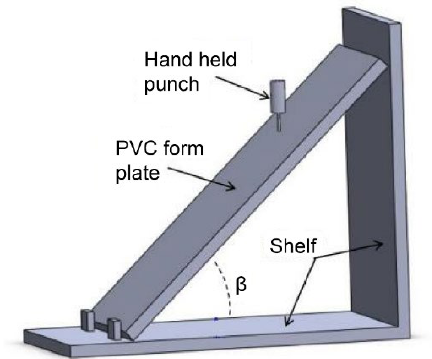
Figure 18. Preparation diagram of the Warren truss slot-hole foam-core plate.